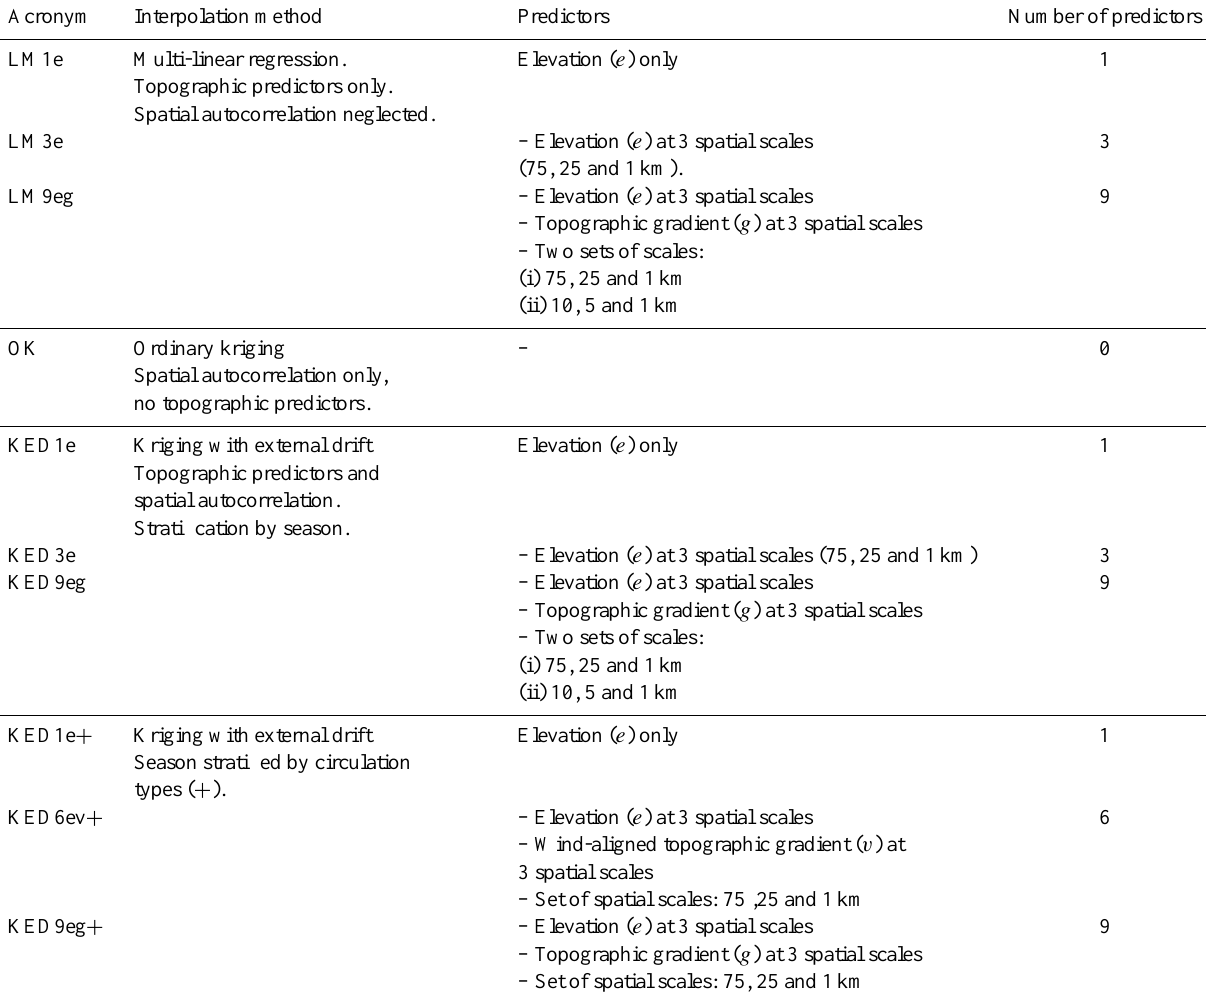
Table 1. Interpolation experiments conducted for long-term seasonal mean precipitation. Interpolation method, predictors used and the total number of predictors included.